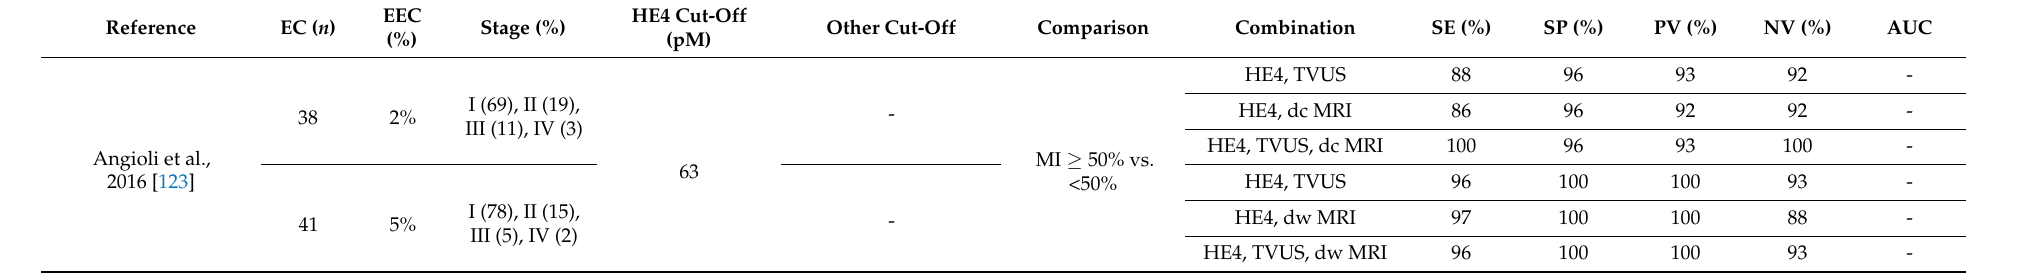
Table 6. HE4 biomarker combinations, cut-off values and their performance in prognosis of